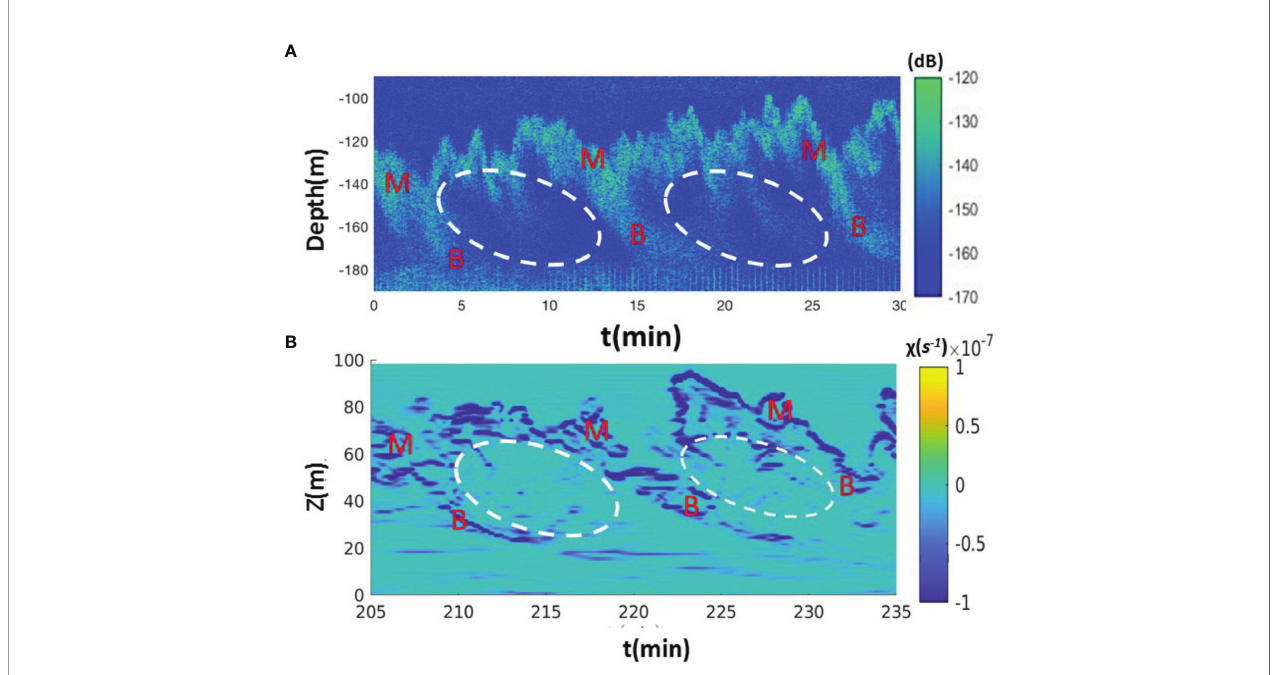
FIGURE 8 | (A) The observed echo intensity. ‘ M-B ’ indicates the location of the braid mixing zone and white circles indicate the core of shear instabilities. Observations were taken between 03/22/2012 06:22:23-06:52:23AM. In the x axis t =0 is set as 03/22/2012 06:22:23. (B) The patterns of the simulated density variance dissipation rate at x =800m (see Figure 4 for the